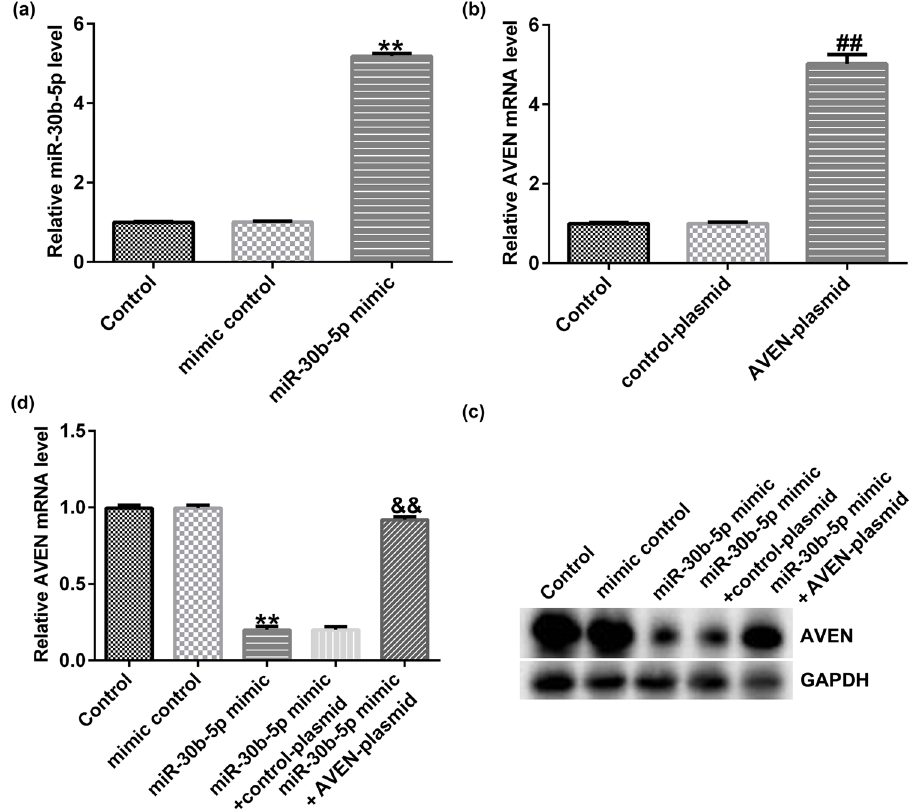
Figure 3: miR - 30b - 5p negatively regulates AVEN expression in SW480/R cells. ( a ) The e ffi ciency of miR - 30b - 5p overexpression was veri fi ed by RT - qPCR assay. ( b ) RT - qPCR was performed to detect the level of AVEN with AVEN plasmid transfection. ( c and d ) RT - qPCR and Western blot was performed to assess AVEN levels in SW480/R cells following miR - 30b - 5p overexpression. Data are represented as the mean value ± SD of three independent experiments. ** P < 0.01 vs Mimic control; ## P < 0.01 vs control - plasmid group; && P < 0.01 vs miR - 30b - 5p mimic + control -